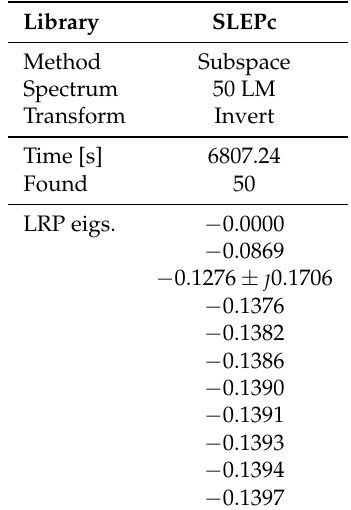
Table 8. AIITS: subspace iteration method,